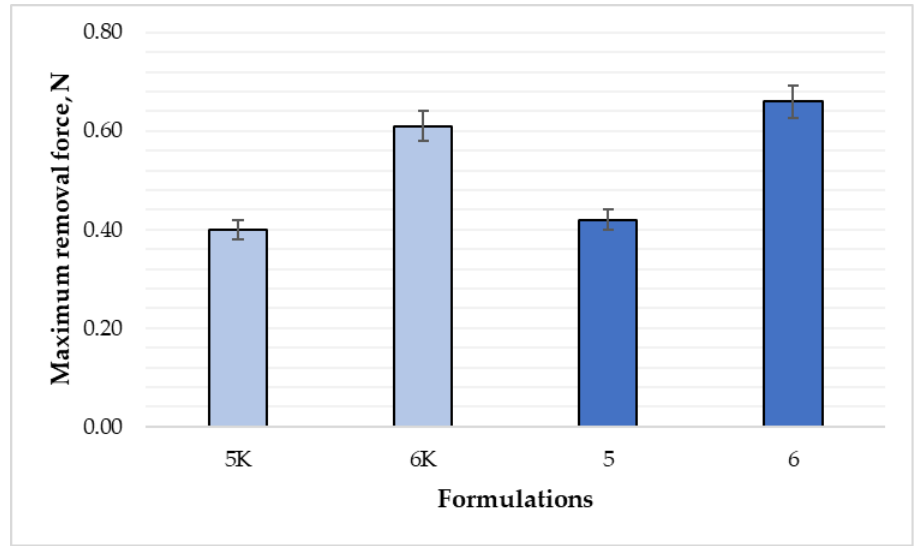
Figure 7. Comparison of film removal force by composition (n = 8). The composition values are given in Table 1. p < 0.05 between 6 and 6K; 5 and 6 compositions; p > 0.05 between 5 and 5K com- positions.